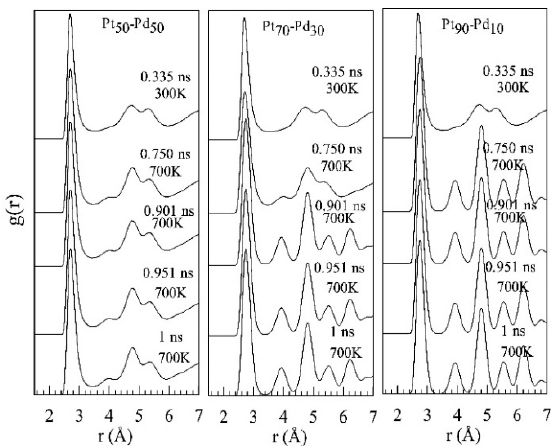
Figure 4. RDF curves obtained at different times and for different temperatures of the process at 300 and 700 K.